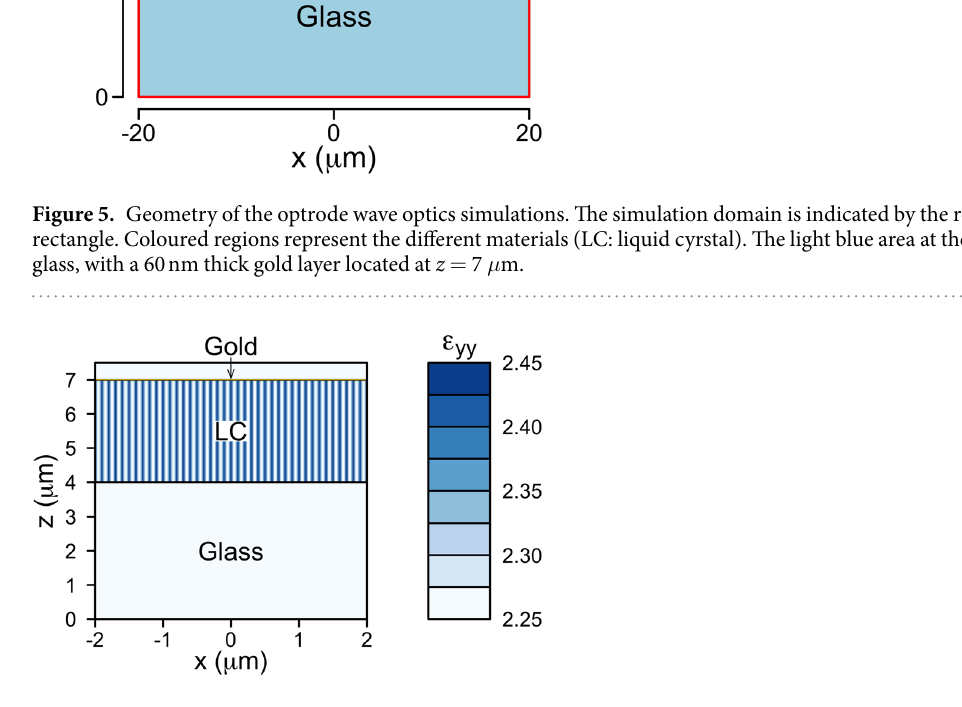
Figure 6. The optical permittivity of the liquid crystal (LC) is periodic along x with a period of 0.2 μ m and behaves as a diffraction grating for light polarised along the y axis. The value of the relative permittivity ε yy (non-dimensional) at t = 0 ms in a small central region of the simulated domain is illustrated (colour legend on the right). The isotropic refractive index of glass is also colour-coded with the same scale for comparison. The horizontal lines represent the boundaries of the